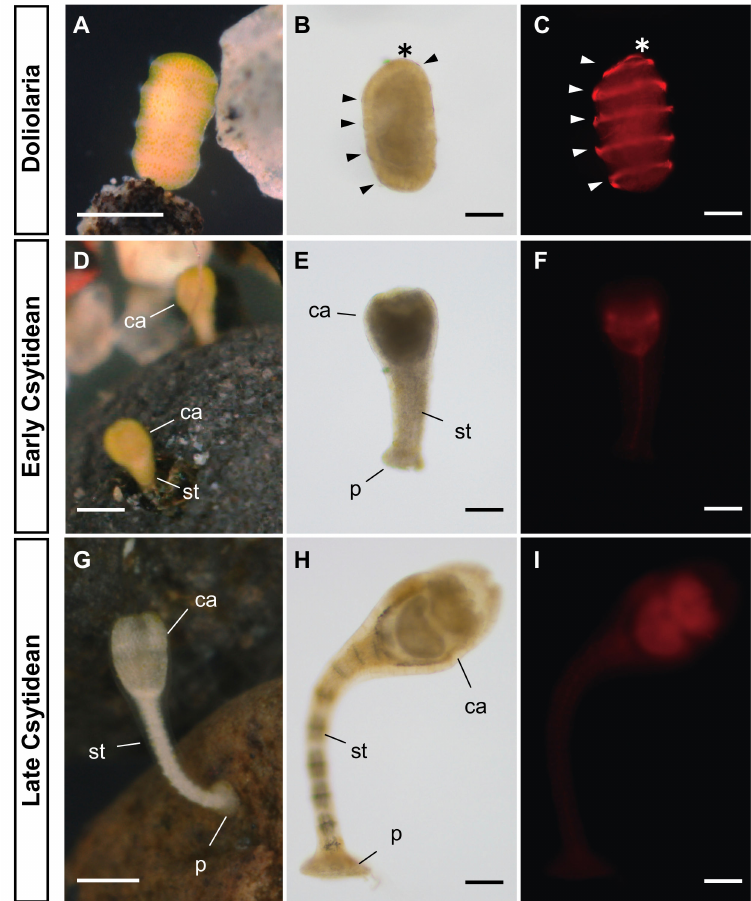
Figure 1. Development process and localization of ciliary bands in the feather star A. serrata . ( A , D , G ) show the living specimens of A. serrata larvae. Competent doliolaria larvae settle to the substrate with the apical tuft ( A ), then commence the metamorphosis process to transit to the csytidean larval phase ( D , G ; approximately two, four days after settlement, respectively). ( D ) shows the early cystidean larvae just after metamorphosis commenced. Calyx (ca), stalk (st) and adhesive plate (p) can be clearly observed in a few days after metamorphosis ( G ). ( B , C , E , F , H , I ) indicates the fixed embryos labeled with anti-acetylated tubulin antibody in doliolaria, early cystidean and late cystidean larvae, respectively (light field; B , E and H , observation of fluorescence; C , F and I ). The specific fluorescence in ciliary bands (arrow heads) and apical tuft (asterisk) were observed in doliolaria larvae ( C ), whereas no specific fluorescence was observed in cystidean larvae ( F , I ). Scale bars: 250 µ m ( A , D , G ), 100 µ m ( B , C , E , F , H , I